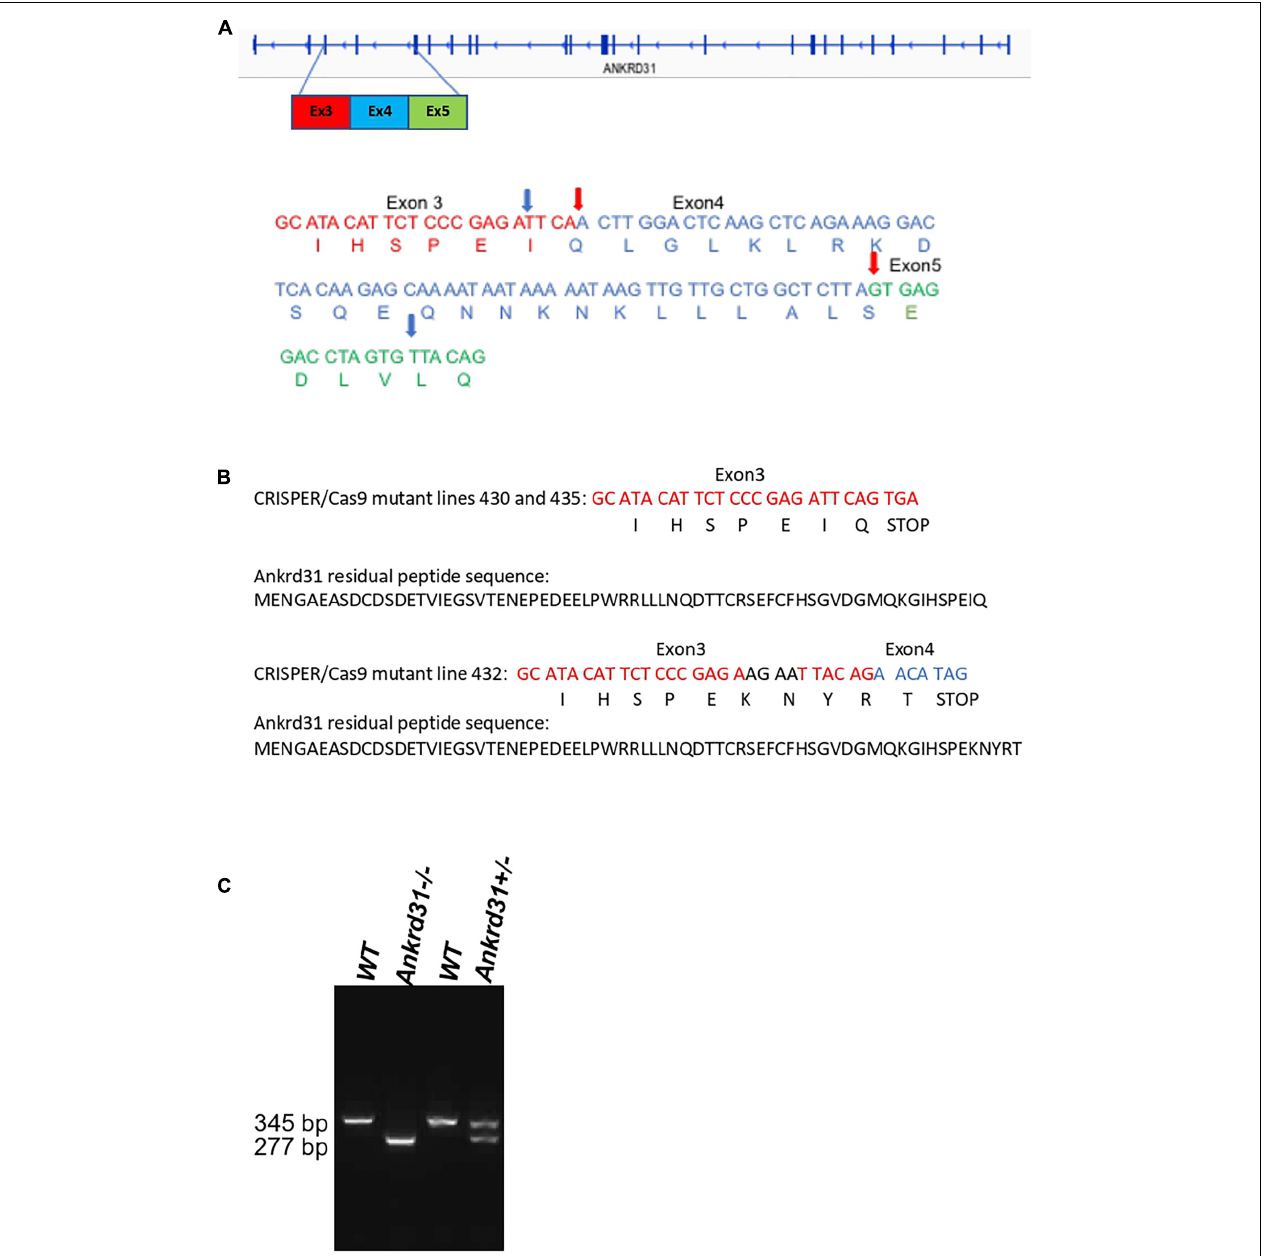
FIGURE 1 | Deletion of exon 4 of the Ankrd31 gene using CRISPR/Cas9 genome editing. The sequences of the two RNA guides are included in section “Materials and Methods.” (A) The entirety of DNA and amino acid sequences of exon 4 (blue) and partial DNA and amino acid sequences of exon 3 (red) and exon 5 (green) are shown in wild type (WT) and in the mutant lines (430, 435, 432). The real cutoff sites observed by sequencing are indicated by red arrows for mutant lines 430 and 435 and blue arrows for mutant line 432. In all mutant lines, a stop codon was generated. (B) The residual peptide sequences of the ANKRD31 protein expressed in the mutant lines are shown. (C) An example of PCR showing the deletion of exon 4. In WT mice, the amplified fragment was 345 bp. In mice with the deletion of exon 4, the amplified fragment was 277 bp.